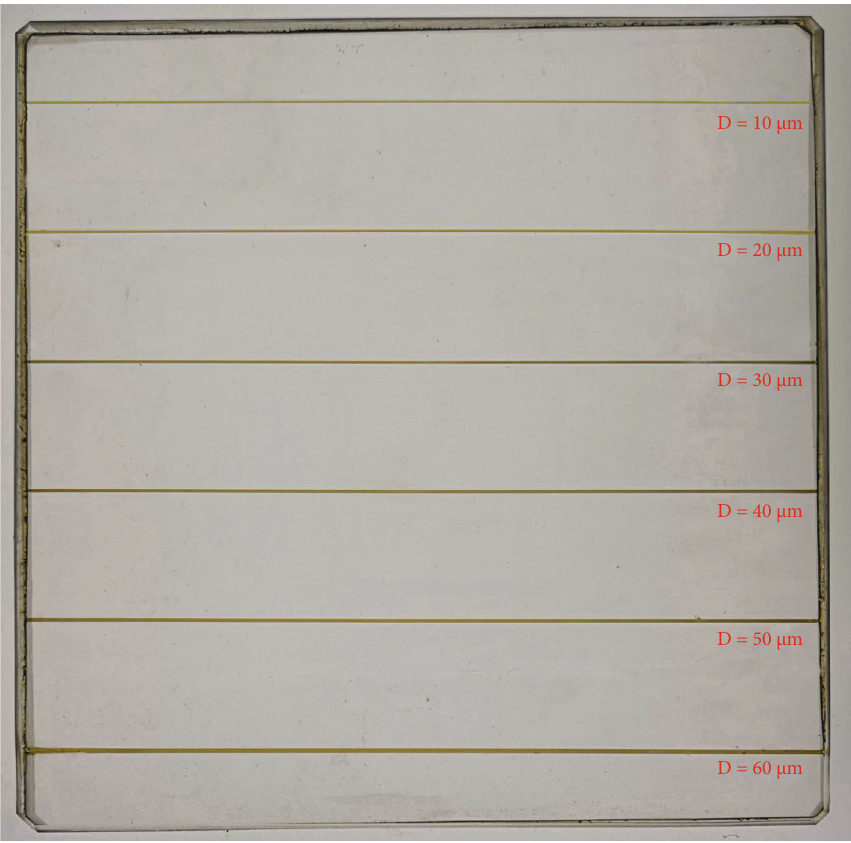
Figure 1: An overhead view of the oil-saturated visualized capillaries with six di ff erent diameters.